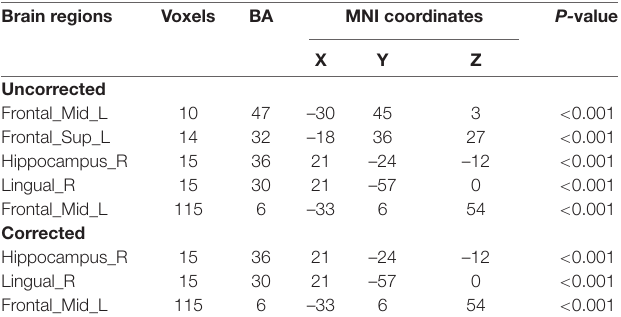
lingual gyrus, and left middle frontal gyrus when compared with healthy controls. We also showed that reduced DC value in the right hippocampus correlated with reduced MoCA and MMSE scores and increased Fazekas score in CAD